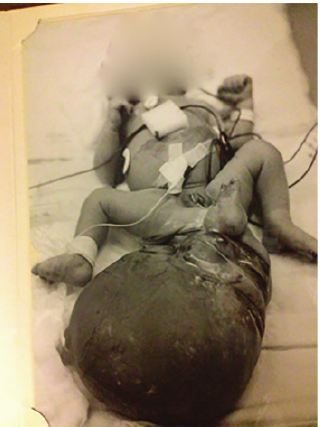
Figure 1: Original photograph of patient with congenital sacrococ- cygeal teratoma at 3 days of age before primary